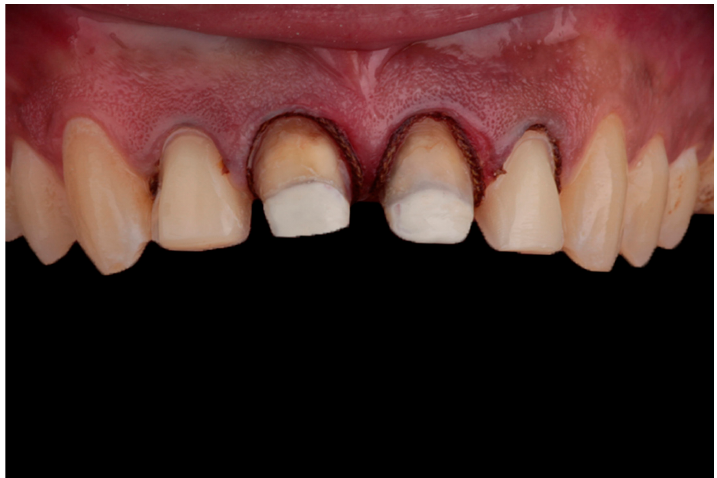
Figure 6. Final preparation with double retraction cord before making impression.